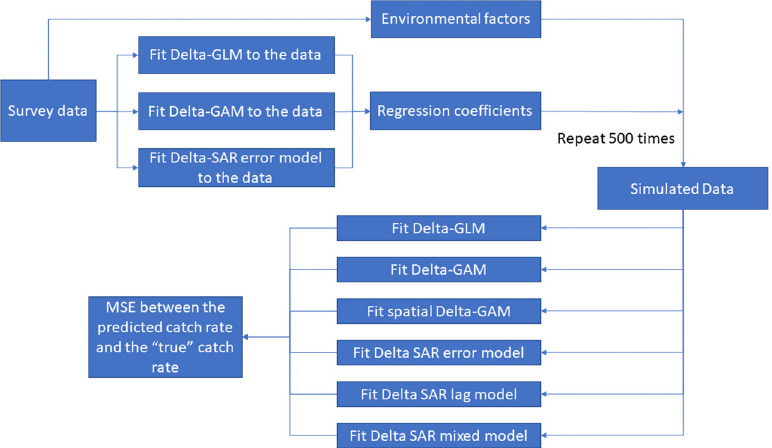
Figure 2. The flow chart of the simulation procedure to estimate the mean squared error (MSE) between the predicted catch rate and the “true” catch rate.